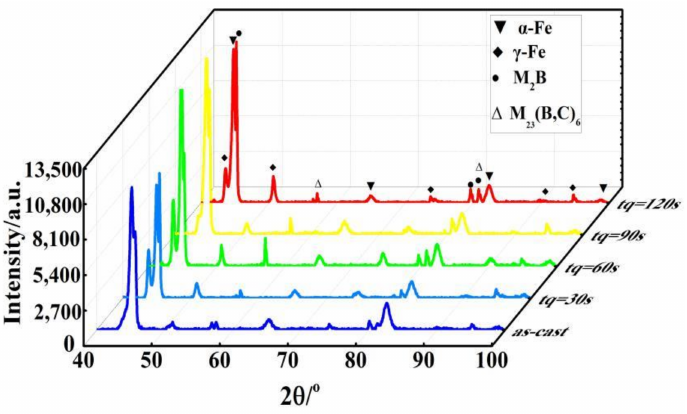
Figure 4. X-ray diffraction (XRD) spectra of samples in the as-cast condition and under different